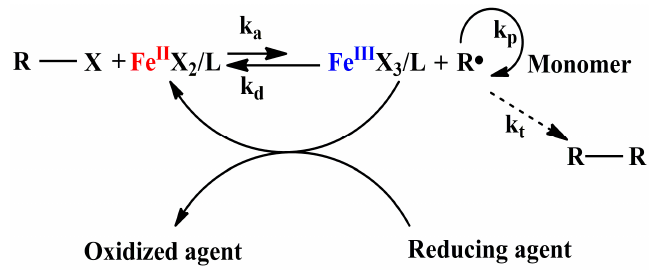
Figure 4. Mechanism of AGET ATRP catalyzed by iron(III) catalyst.